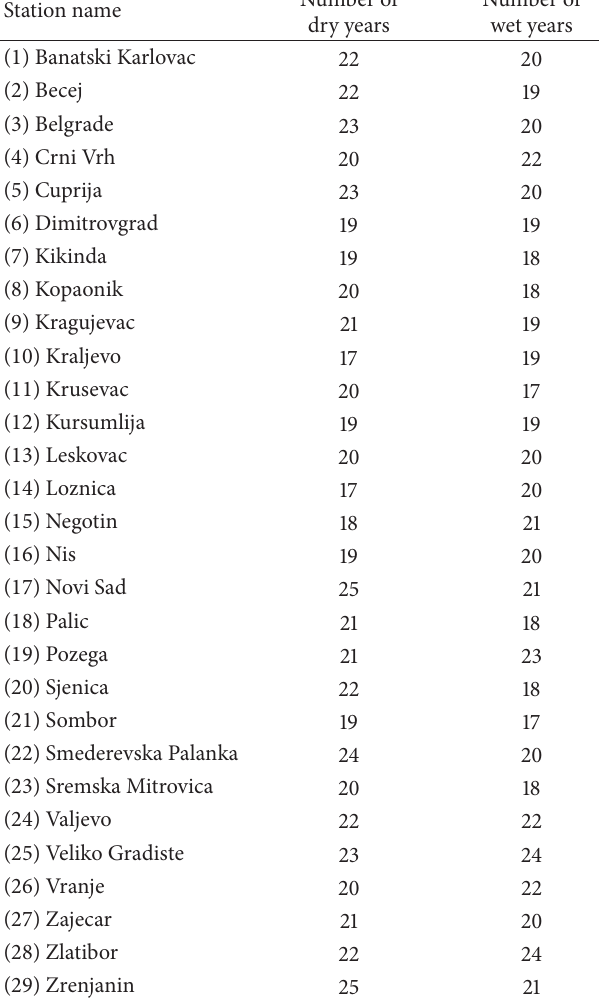
Table 2: Number of dry and wet years for the synoptic stations used in the